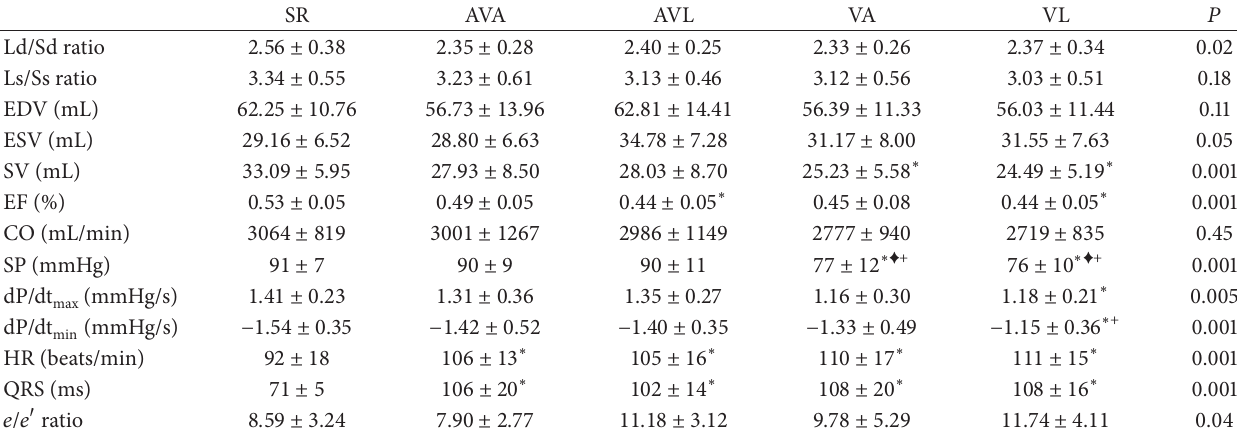
Table 1: Comparison of the hemodynamic and conventional echocardiographic variables between sinus rhythm and pacing in various modes and sites. SR AVA